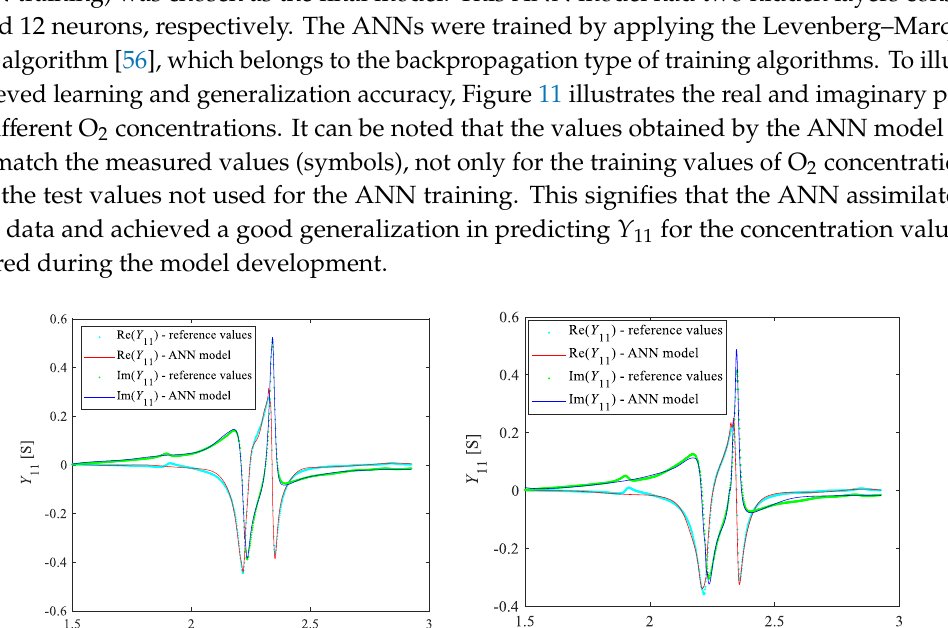
Figure 10. Frequency dependence of the real and imaginary parts of Y 11 at 70% of the O 2 concentration: (symbols) measurements and (lines) ANN simulations.